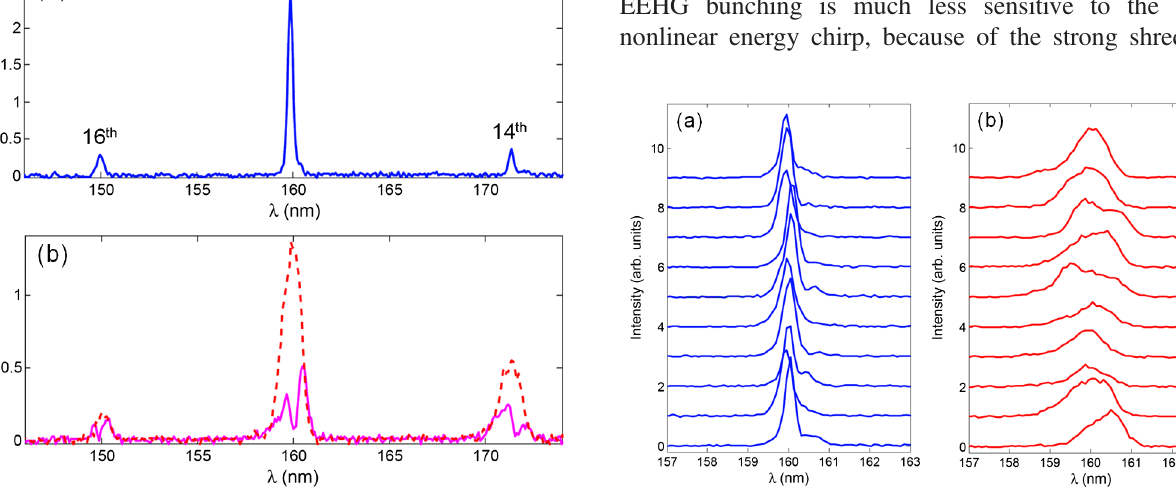
FIG. 4. Representative single-shot radiation spectrum for EEHG (a) and HGHG (b).